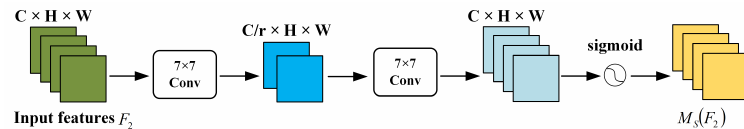
Figure 7. Spatial attention